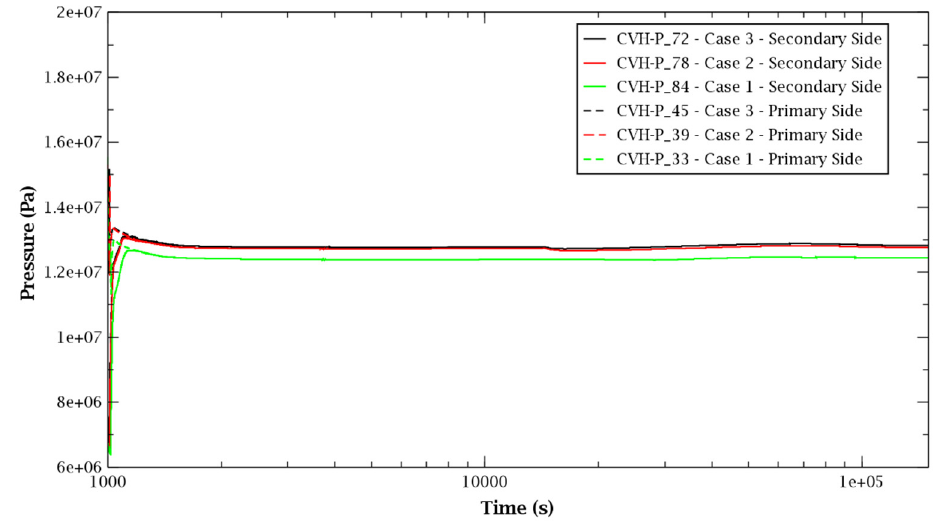
Figure 9. Pressure trend after the rupture: primary and secondary sides.